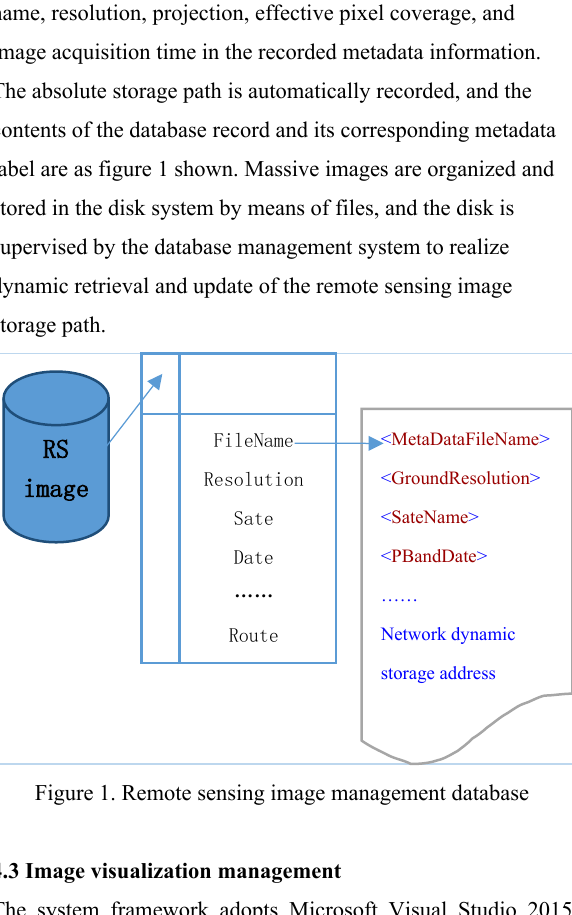
Figure 1. Remote sensing image management